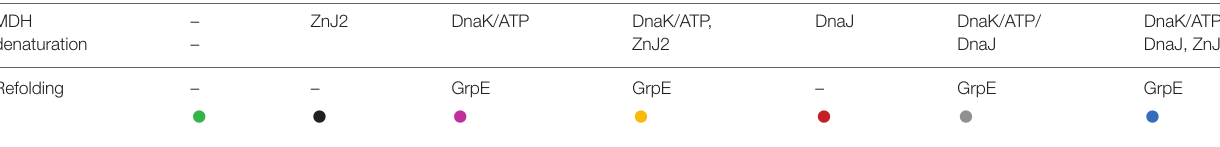
FIGURE 6 | ZnJ2 does not interact with the KJE system in MDH refolding assay. Native MDH was heat denatured in 47 ◦ C for 30 ′ in the absence ( • ) or presence of different chaperone combinations. These included DnaK/ATP, GrpE, and DnaJ ( • ), DnaK/ATP, GrpE, and ZnJ2 ( • ), DnaK/ATP along with GrpE, DnaJ, and ZnJ2 ( • ), DnaK/ATP and GrpE ( • ), DnaJ alone ( • ), and ZnJ2 alone ( • ). Refolding in these tubes was performed at room temperature (25 ◦ C). GrpE was added during the refolding to assay tubes that contained DnaK/ATP. Refolding was monitored in the presence of pyruvate kinase and phosphoenol pyruvate. Aliquots were removed at various intervals (0, 10, 40, 80, 160min) and MDH activity was monitored at 340nm. The percentage of refolding was calculated relative to activity of native MDH. Similar results were obtained in two independent